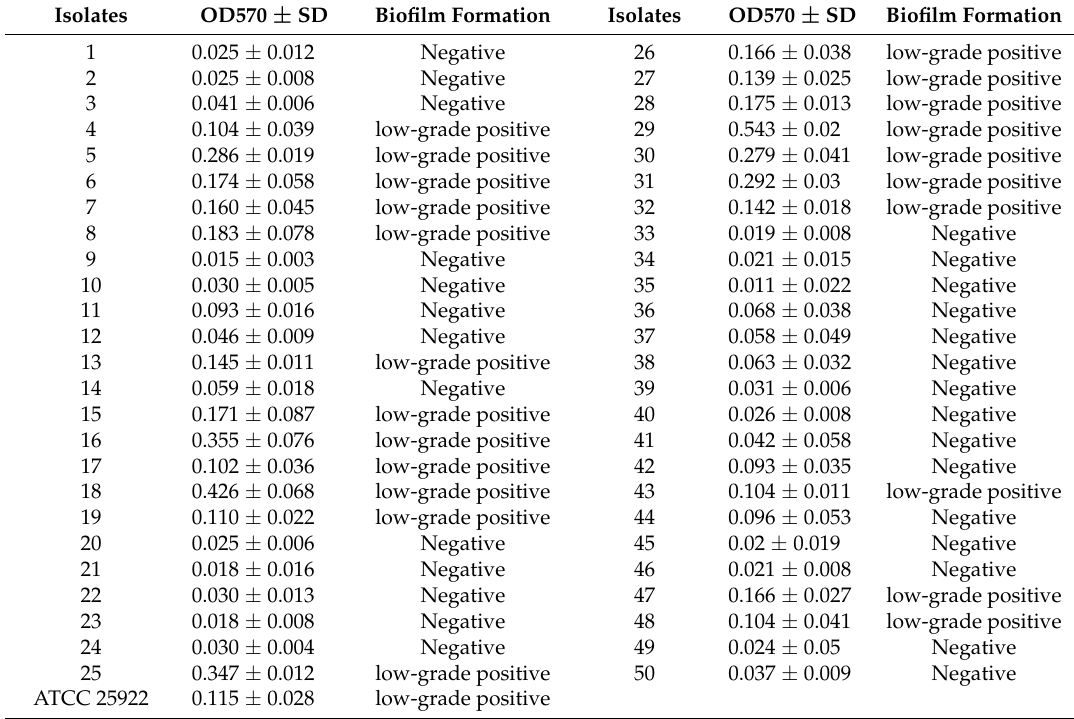
Table 4. Biofilm formation on polystyrene surface of E. coli